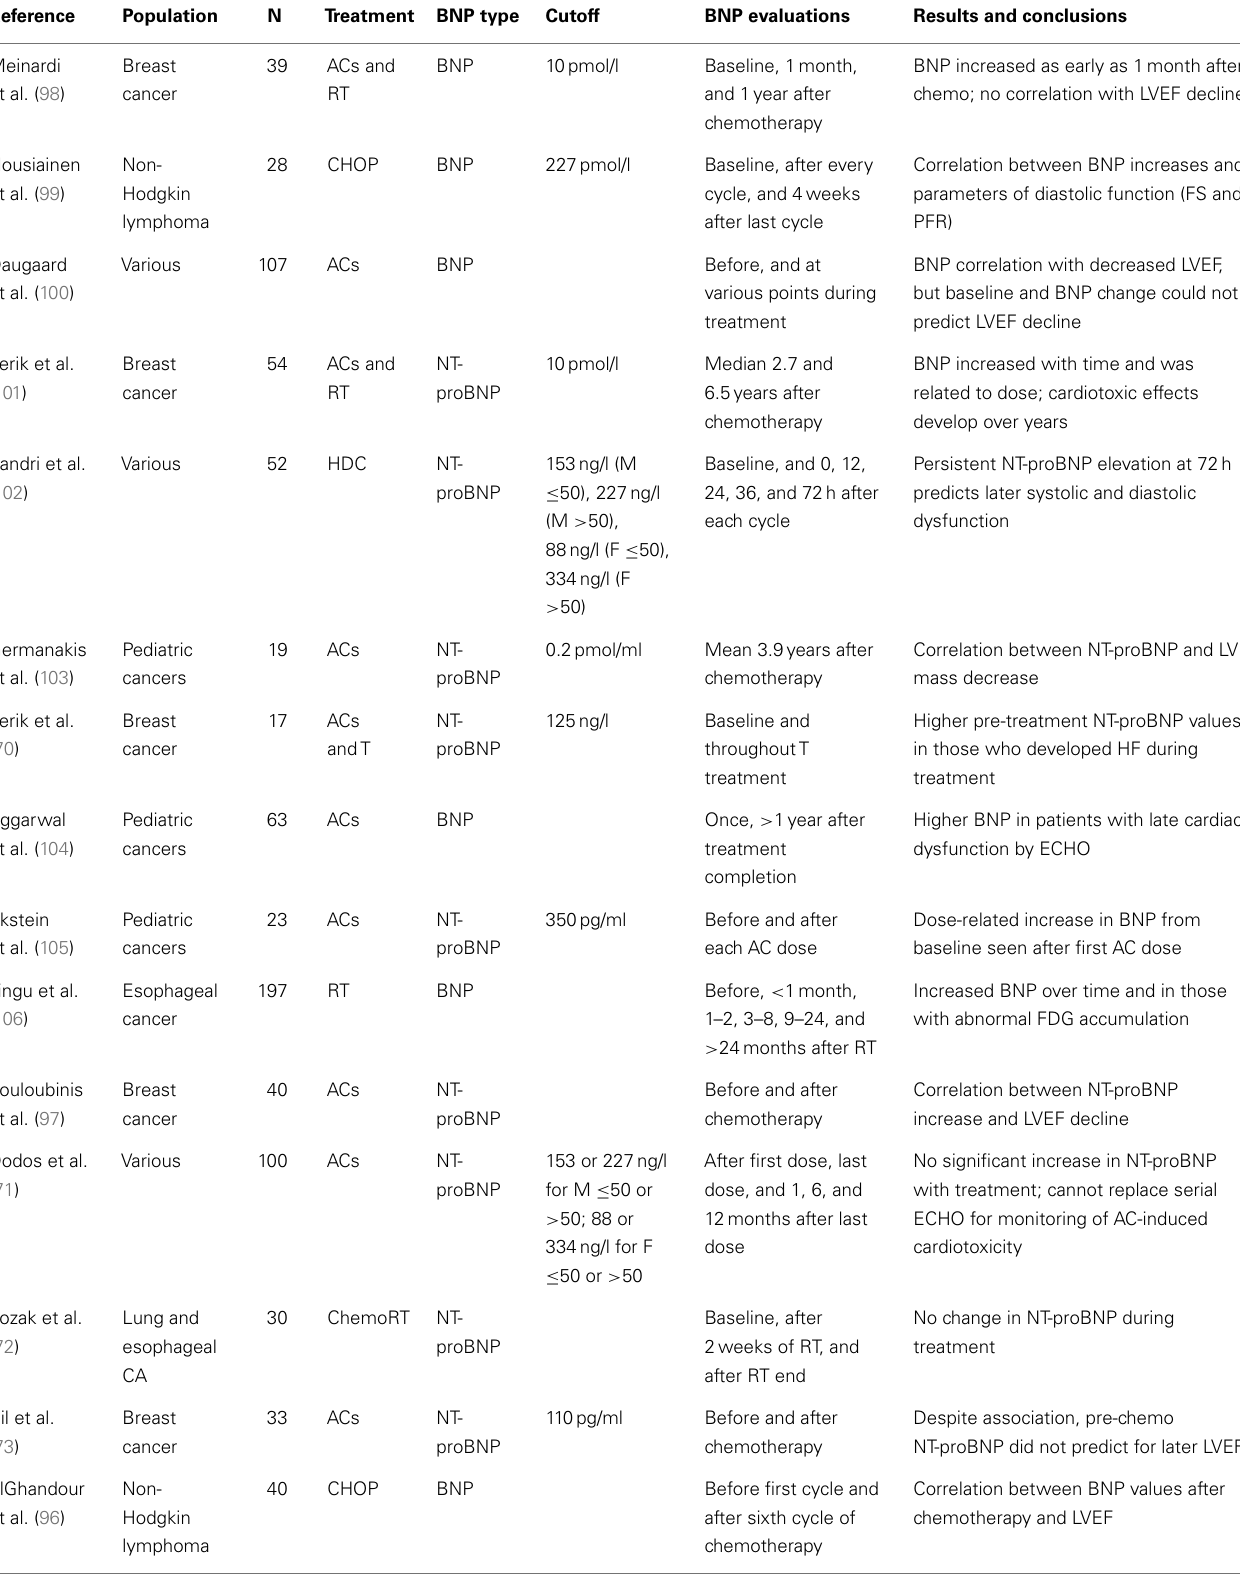
Table 2 | Role of natriuretic peptides in the evaluation of chemotherapy and radiation-induced cardiotoxicity